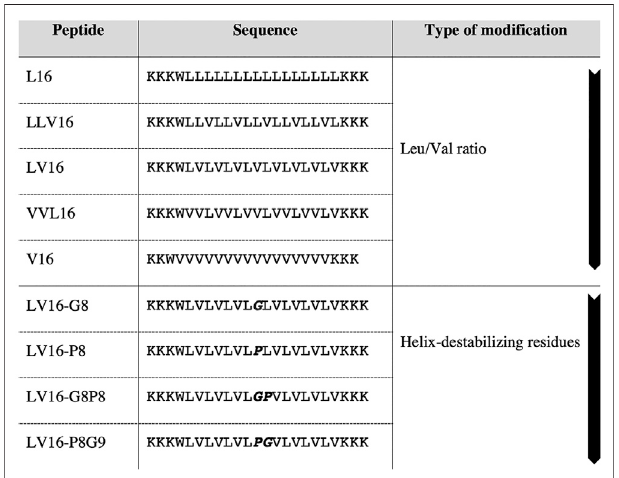
FIGURE 5 | Design of fusogenic peptides containing different ratios of helix promoting, β -sheet-promoting or helix destabilizing residues (in bold) adapted from Hofmann et al. The fi rst arrow indicates the increase ofVal ratio. The second arrow indicates the increase of helix destabilization (Hofmann et al.,